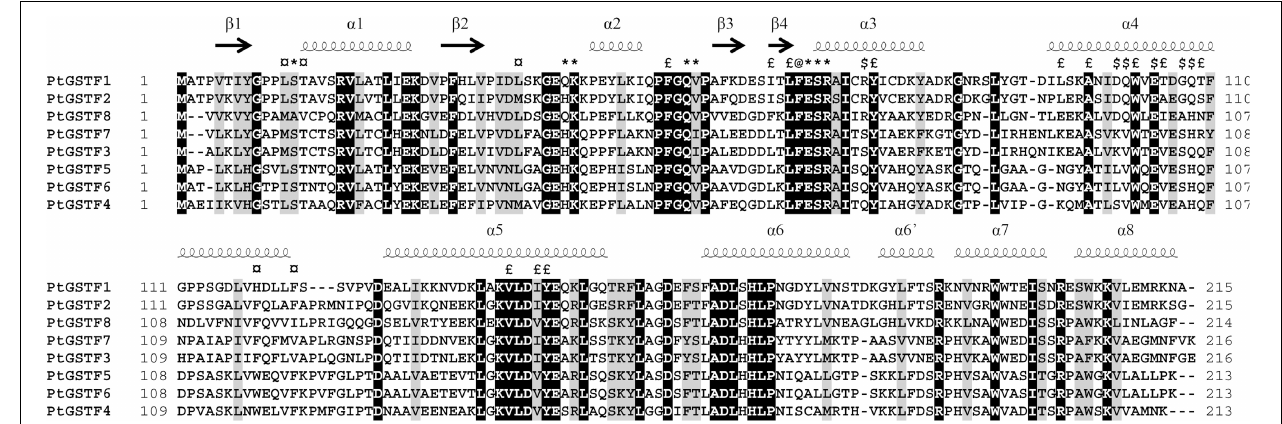
FIGURE 1 | Structure based sequence alignment of Populus trichocarpa GSTFs. The structural alignment was calculated with PROMALS3D using the structure of PttGSTF1 and rendered using ESpript 3.0. Accession numbers of GSTFs from the version 3.0 of P. trichocarpa genome are the following: PtGSTF1: Potri.002G015100, PtGSTF2: Potri.002G015200, PtGSTF3: Potri.014G132200, PtGSTF4: Potri.T035400, PtGSTF5: Potri.T035300, PtGSTF6: Potri.T035100,